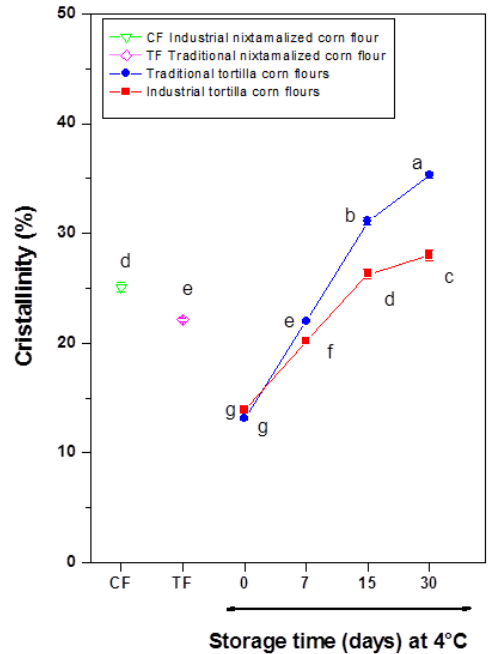
Figure 5. Total relative crystallinities of corn flours and corn tortilla flours obtained by the industrial (commercial) and traditional methods without refrigeration (TF, CF, TR0, CF0) and stored in refrigeration (4 ◦ C) at di ff erent periods of time (7, 15, and 30 days). Di ff erent letters means di ff er